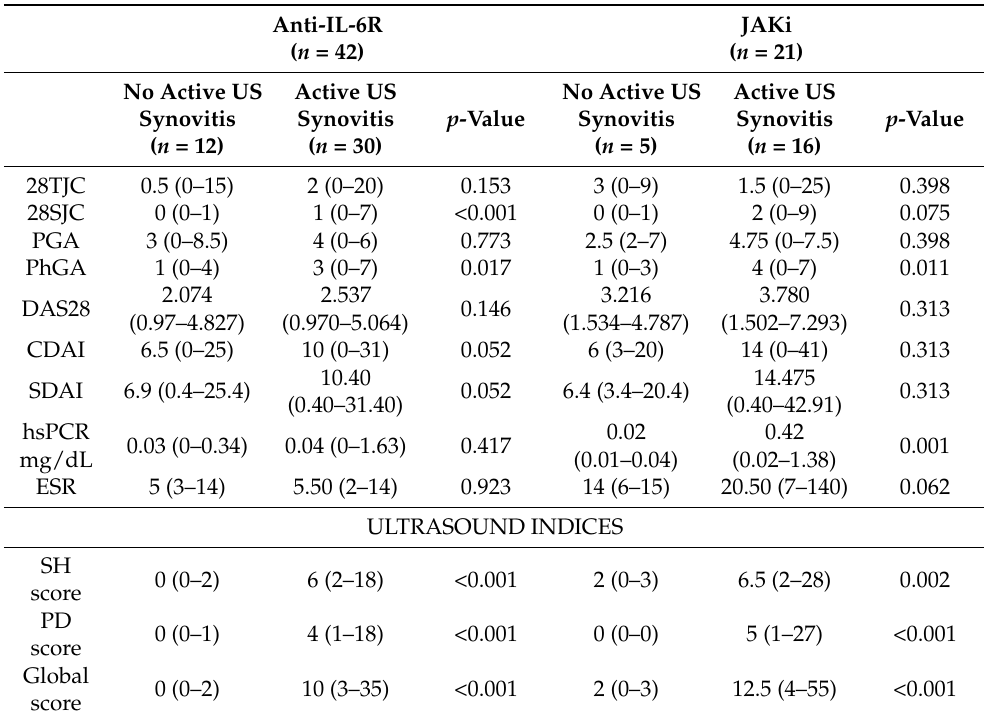
Table 4. Clinical and ultrasound disease activity according to the presence or absence of ultrasound synovitis in anti-IL-6R and Jaki groups.